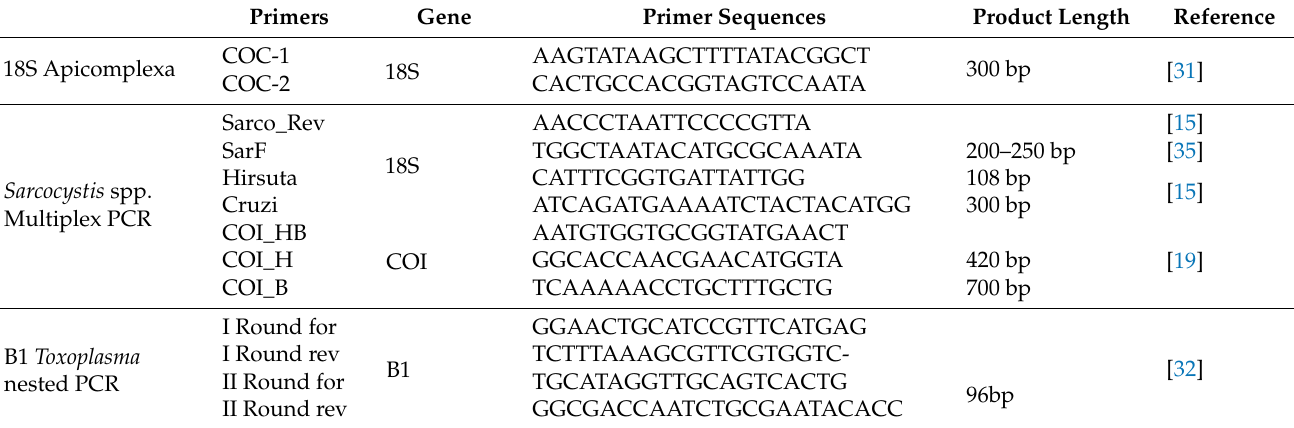
Table 1. Forward and reverse primers used in the different PCR assays. Primers Gene Primer Sequences Product